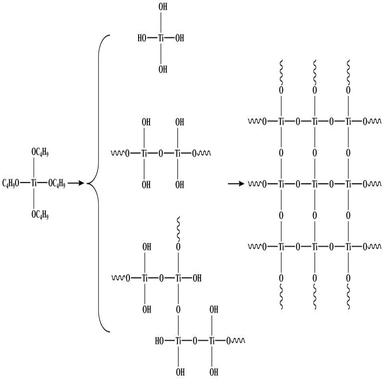
The schematic diagram of synthesized TNTs.